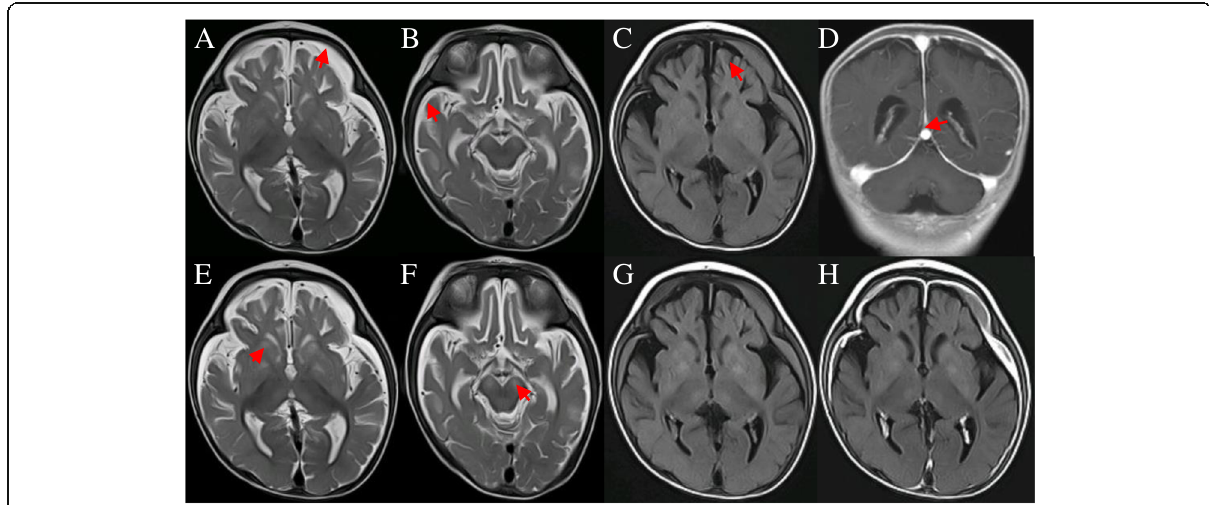
Fig. 1 3T Brain MRI of the patient: a to d were performed when he was first transfer to our hospital at 4-month-old. a and b : axial T2WI showed arc-shaped subdural empyema was seen in bilateral frontotemporal parietal lobes. c : axial T2 Flair showed arc-shaped subdural empyema and bilateral cerebral hemisphere atrophy. d : Coronal T1WI enhanced scanning showed bilateral frontotemporal parietal dura enhanced which was called Mercedes-Benz sign. e to h was reexamined 7 days after hospitalization. e and f : axial T2WI showed new symmetrical hypersignal lesions in bilateral basal ganglia, thalamus and cerebral peduncle. g : the lesions had a slightly higher signal on T2Flair. h : the lesions had no obvious enhancement on T2Flair